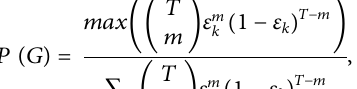
Table 1 . The fi nal library was generated by PCR ampli fi cation using Phusion PCR Master Mix (NEB, Ipswich, MA, USA) for 15 cycles. The fi nal cSMART library was mixed and sequenced on an Illumina MiSeq platform (Illumina, San Diego, CA, USA) in the 250 bp × 2 paired-end mode.